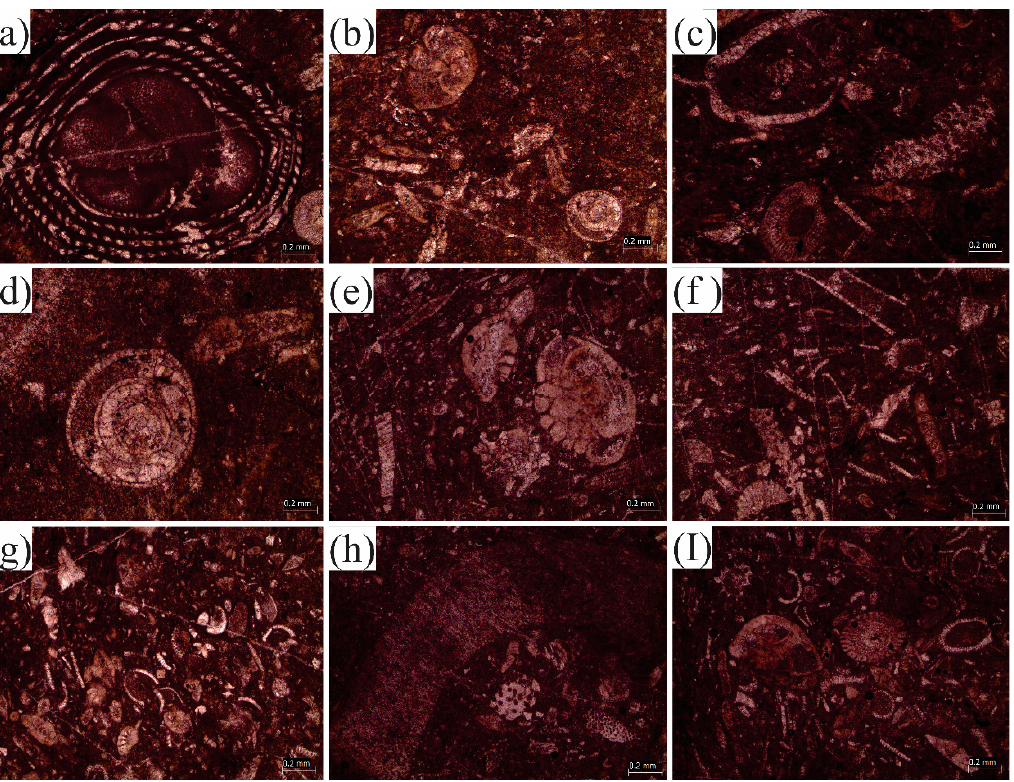
Figure 8. Photomicrographs showing ( a ) Alveolina spp.; ( b ) Austrotrillina eocenica on the right and Operculina subsalsa on the left; ( c ) Gymnocodacea in the bottom, ostracods in the top left, and sponge in the middle right; ( d ) Idalina grelaudae (Middle Eocene milliolid); ( e ) Lockhartia prehaimei on the right and Lockhartia tipperi on the left; ( f ) Dascycladacean green alga and Cymopolia elongata on top; ( g ) high concentration of green algae; ( h ) Fabiania spp.; and ( I ) Rotalia trochidiformis and echinoid spine .